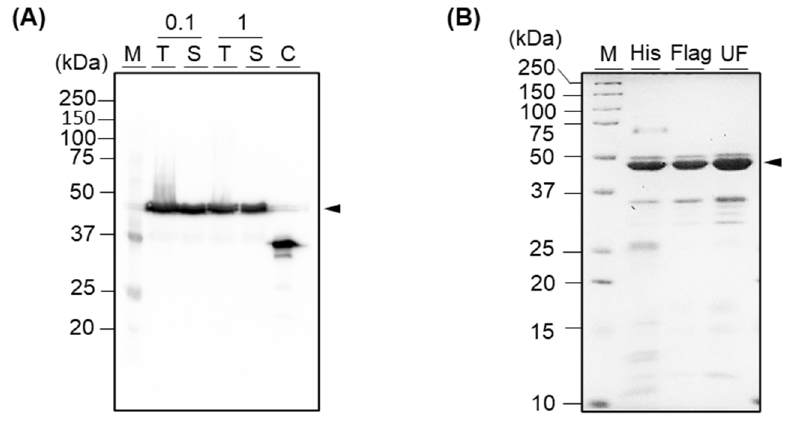
Figure 3. ( A ) Western blot analysis of recombinant fusion protein, which was induced with 0.1 mM or 1 mM of IPTG. M, T, S, C, and numbers indicate marker, total reagent after sonication, superna- tant after centrifugation of the sonicated protein, control, and IPTG concentration, respectively. Anti-mPD-L1 scFv without Neo-IL2/15 was used as a control. ( B ) SDS-PAGE analysis of His-tag purified protein (His), His-tag- followed by Flag-tag-purified protein (Flag), and His-tag- followed by Flag-tag-purified and ultra-filtrated protein (UF). M indicates marker. Arrow indicates the target